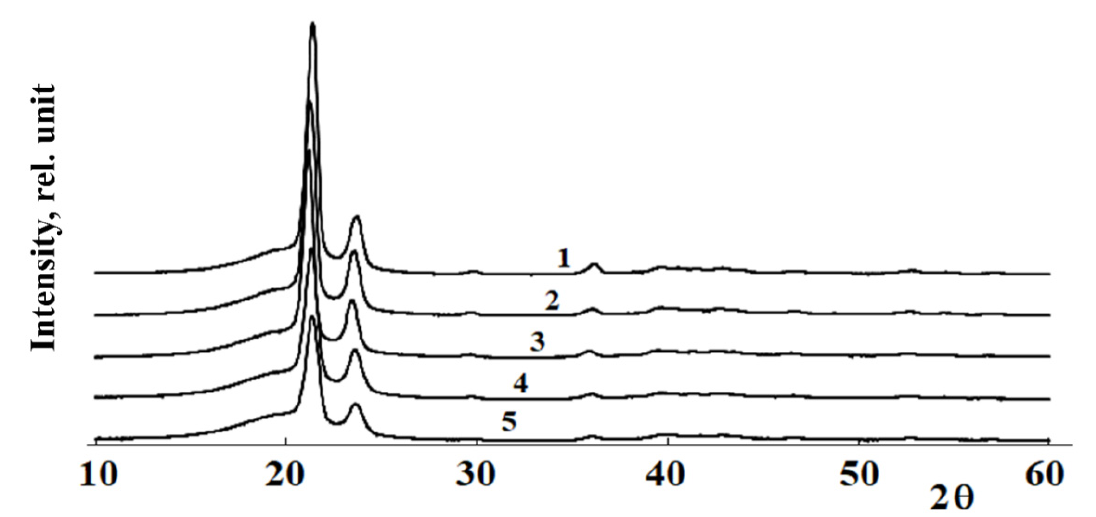
Figure 5. Diffractograms of HDPE-1/LLDPE compositions with compositions (1) HDPE; (2) 80/20; (3) 50/50; (4) 20/80; (5) LLDPE.